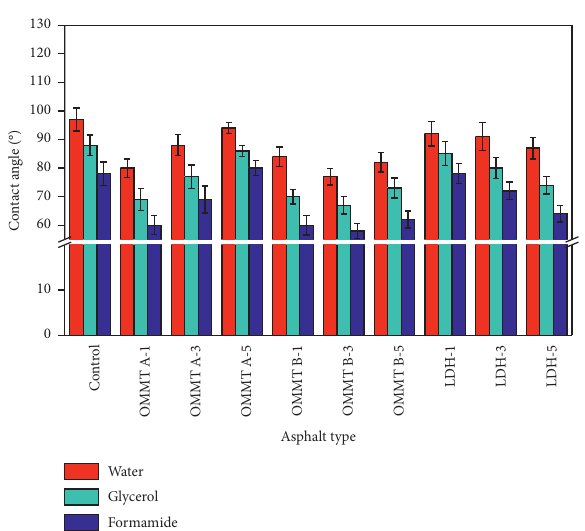
Figure 3: Average contact angles for the probe